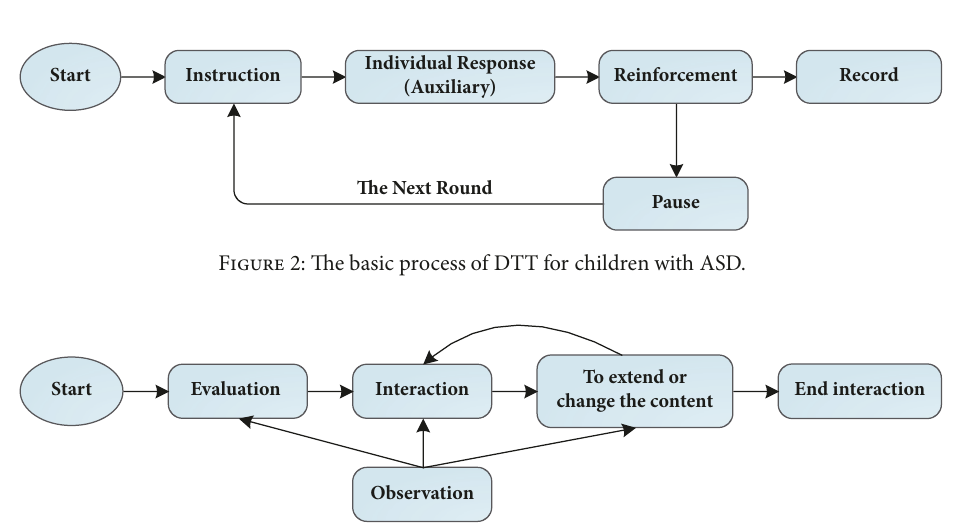
Figure 3: The basic process of DIR/Floortime for children with